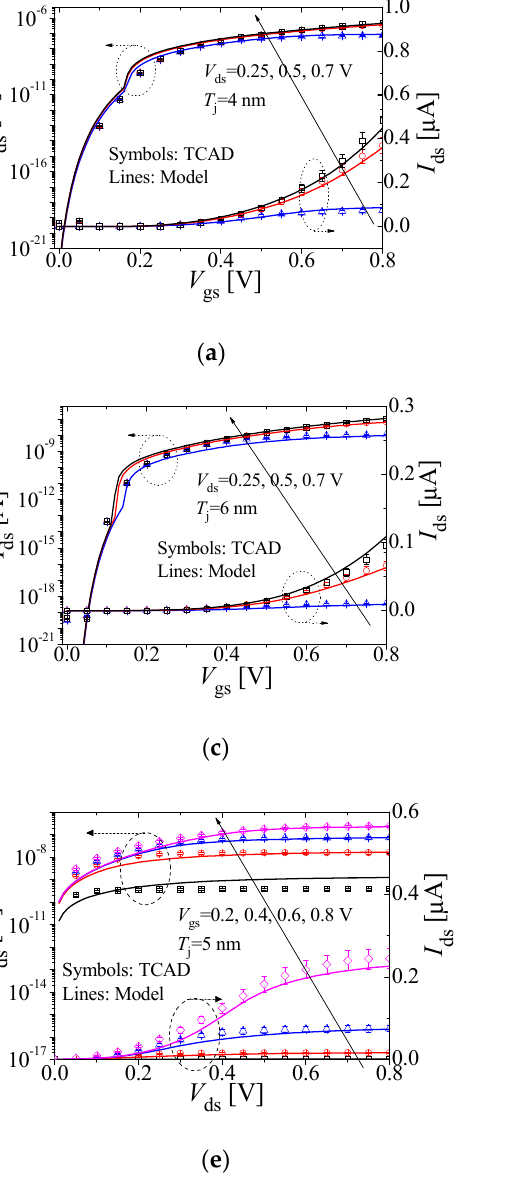
Figure 8. I ds – V gs characteristics of LTFET with T j = 4 nm, H overlap varied, and V ds = 0.5 V. Blue, red, and black represent H overlap = H s = 40, 50, and 60 nm, respectively. Symbols and lines denote TCAD simulation and model results, respectively. Error bar: 10%.